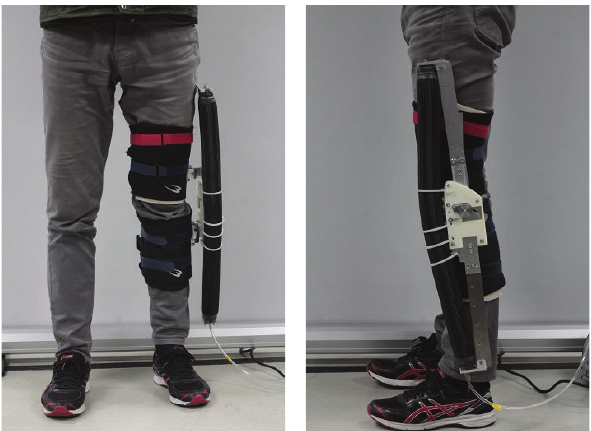
Figure 17: Device attached on the body.